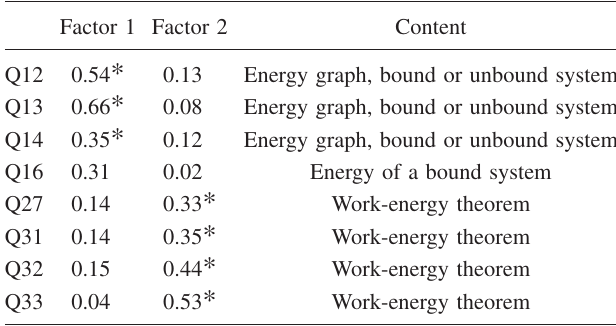
TABLE IV. Factor loadings for common factor analysis of eight MIET